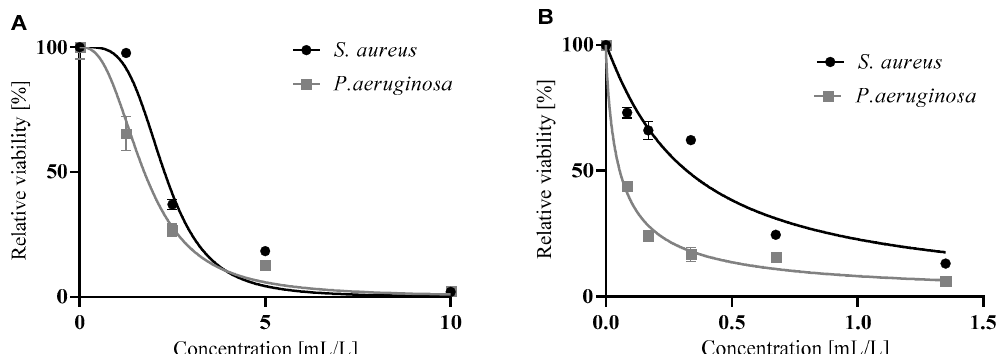
Figure 2. Inhibition of adhesion of bacteria forming a biofilm by lemongrass essential oil ( A ) and citral ( B ). The data are presented as an average of 16 repetitions with SEM.